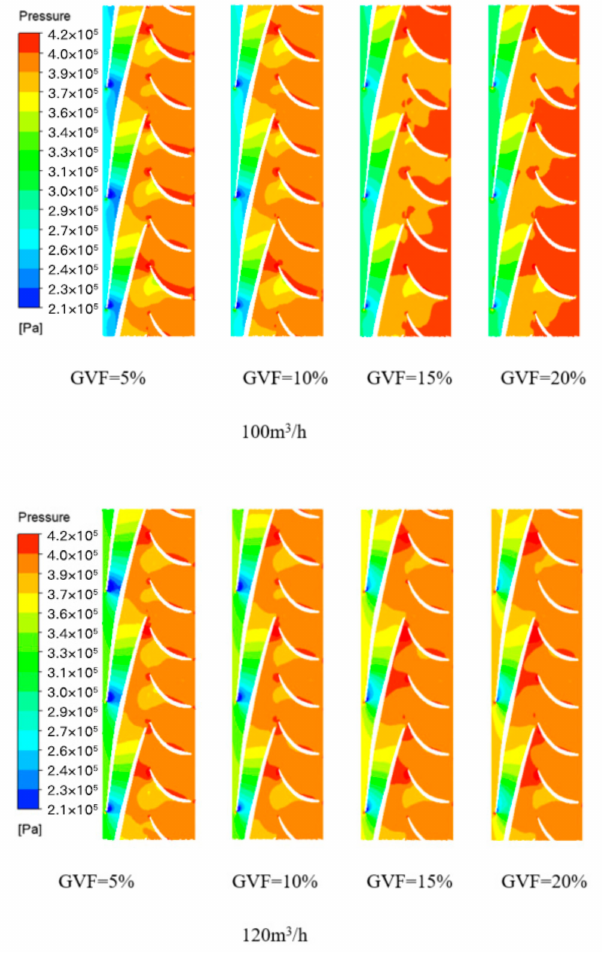
Figure 9. Static pressure distribution of multiphase pump under different